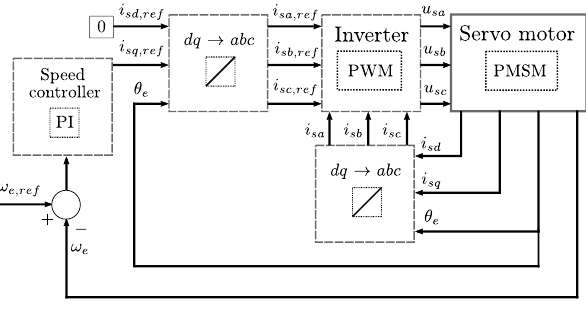
Figure 10: Field-oriented control of